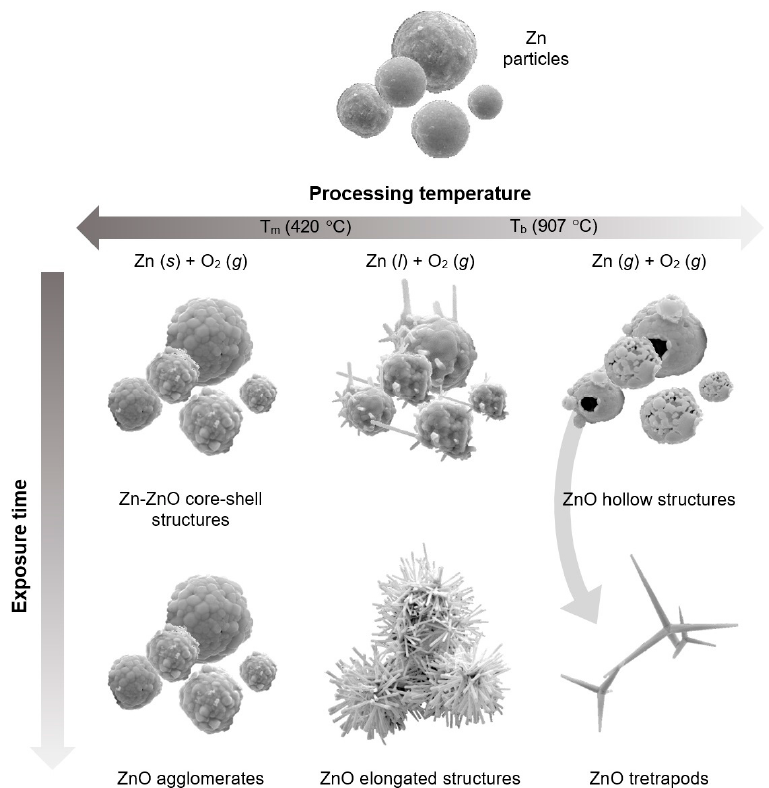
Figure 4. Scheme of the proposed growth mechanisms of ZnO structures obtained by thermal oxidation of zinc powders.